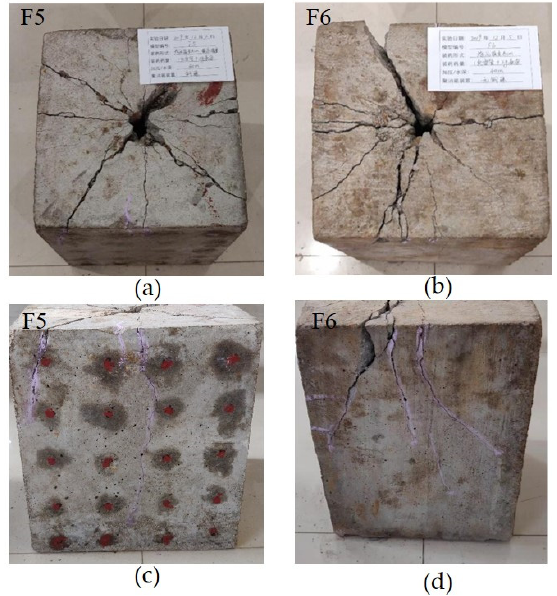
Figure 11. Specimens ( a , c ) F5 and ( b , d ) F6 after blasting.